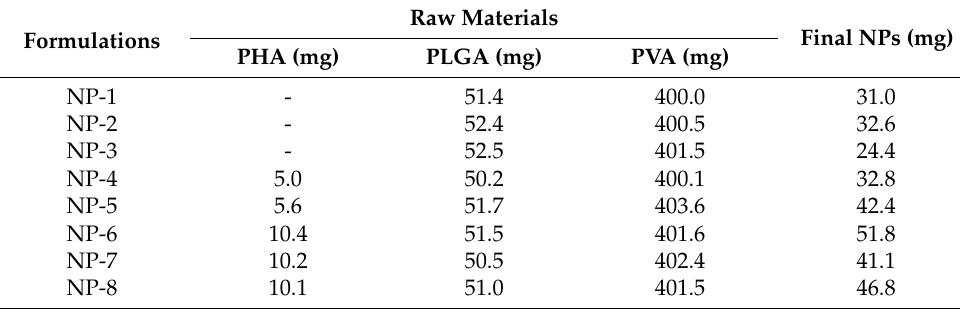
Table 1. Formulations for blank and drug-loaded nanoparticles preparation.